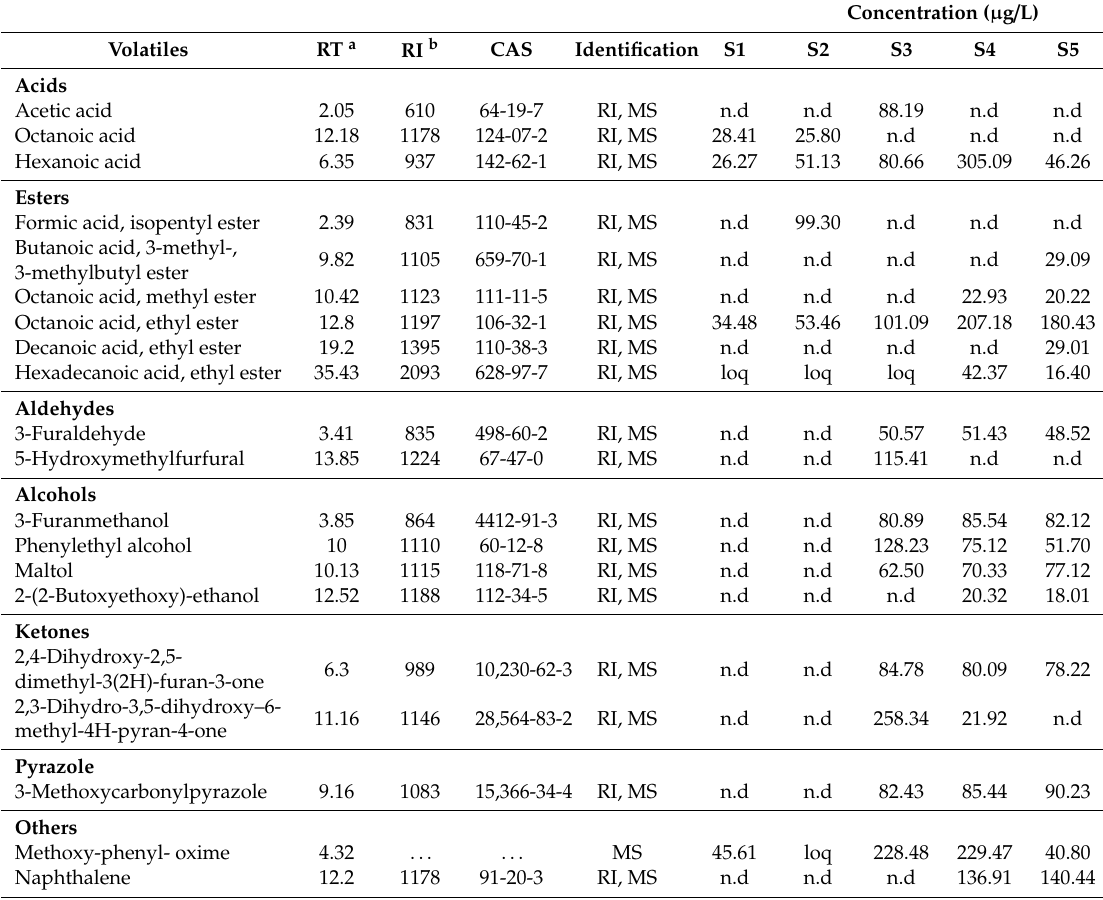
Table 2. Volatile compounds of the yogurt samples identified by